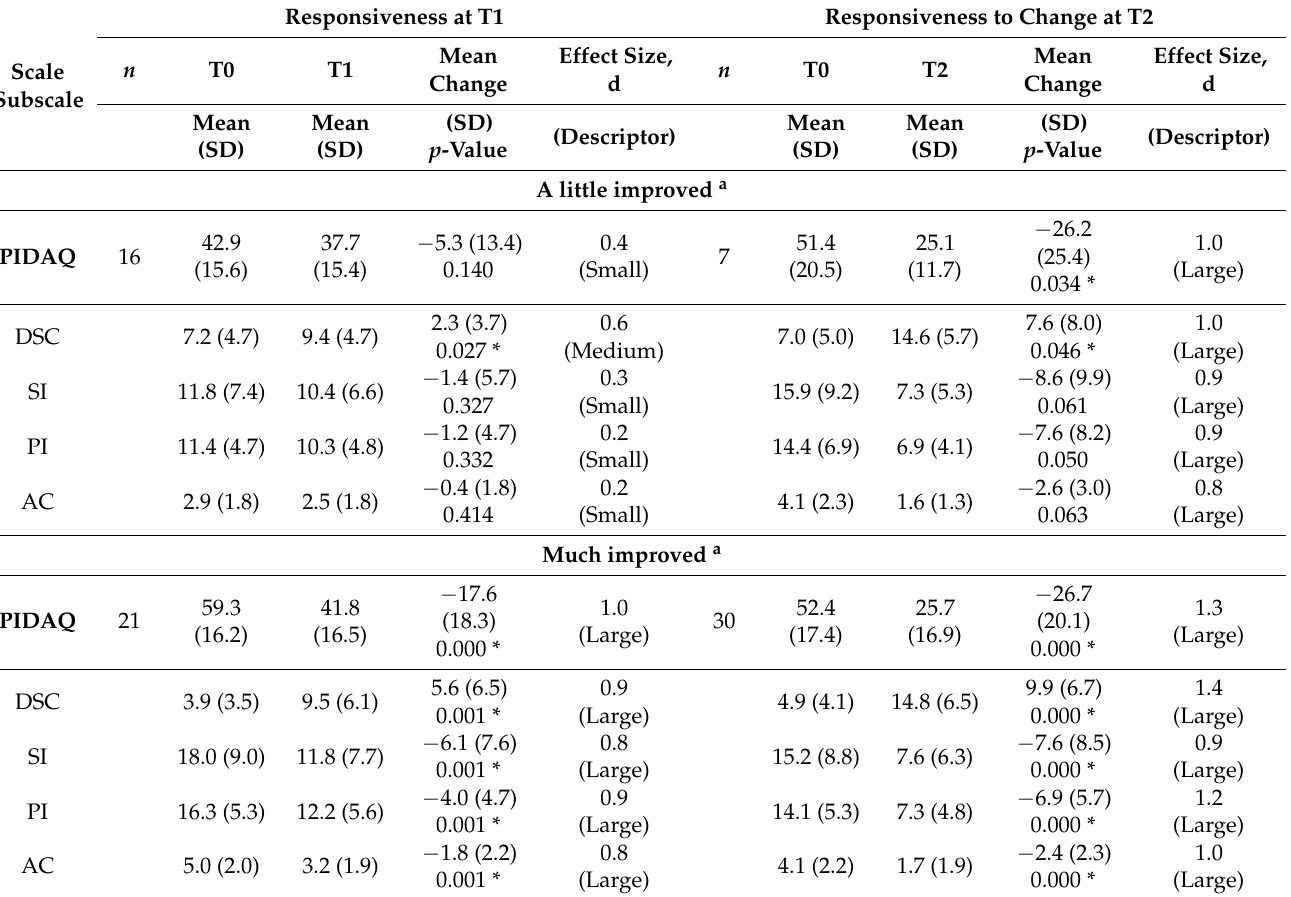
Table 5. Responsiveness of the Malaysian psychosocial impact of dental aesthetics questionnaire (PIDAQ) to changes based on the global health transition scale following orthodontic treatment ( N =